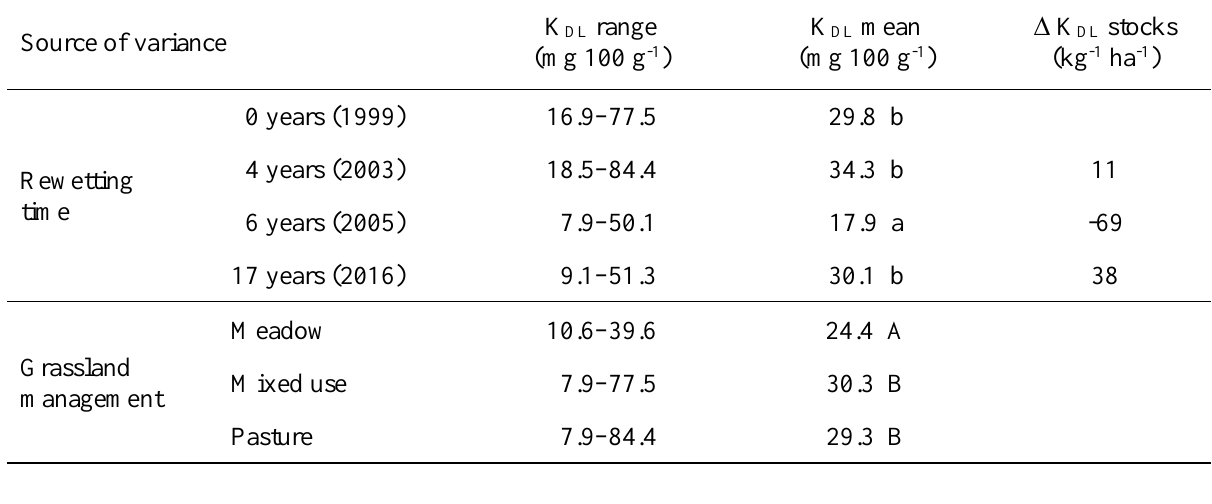
Table 4. Two-way ANOVA results of transformed K DL values. The influence of rewetting time, type of grassland management and the interaction of both variables on K DL contents (topsoil, 0–10 cm) was examined.